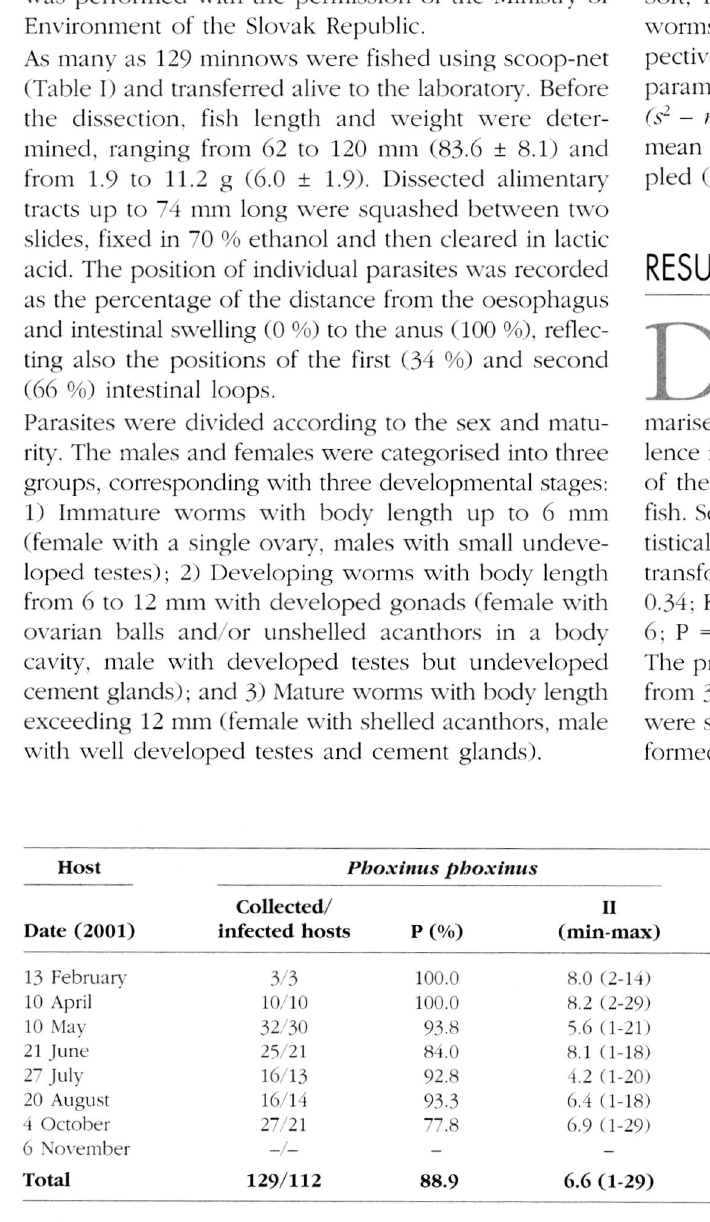
Table I. - Seasonal changes in the prevalence (P) and intensity of infection (II) of Pomphorhynchus laevis in the fish and crustacean hosts in the Small Vihorlat Lake.